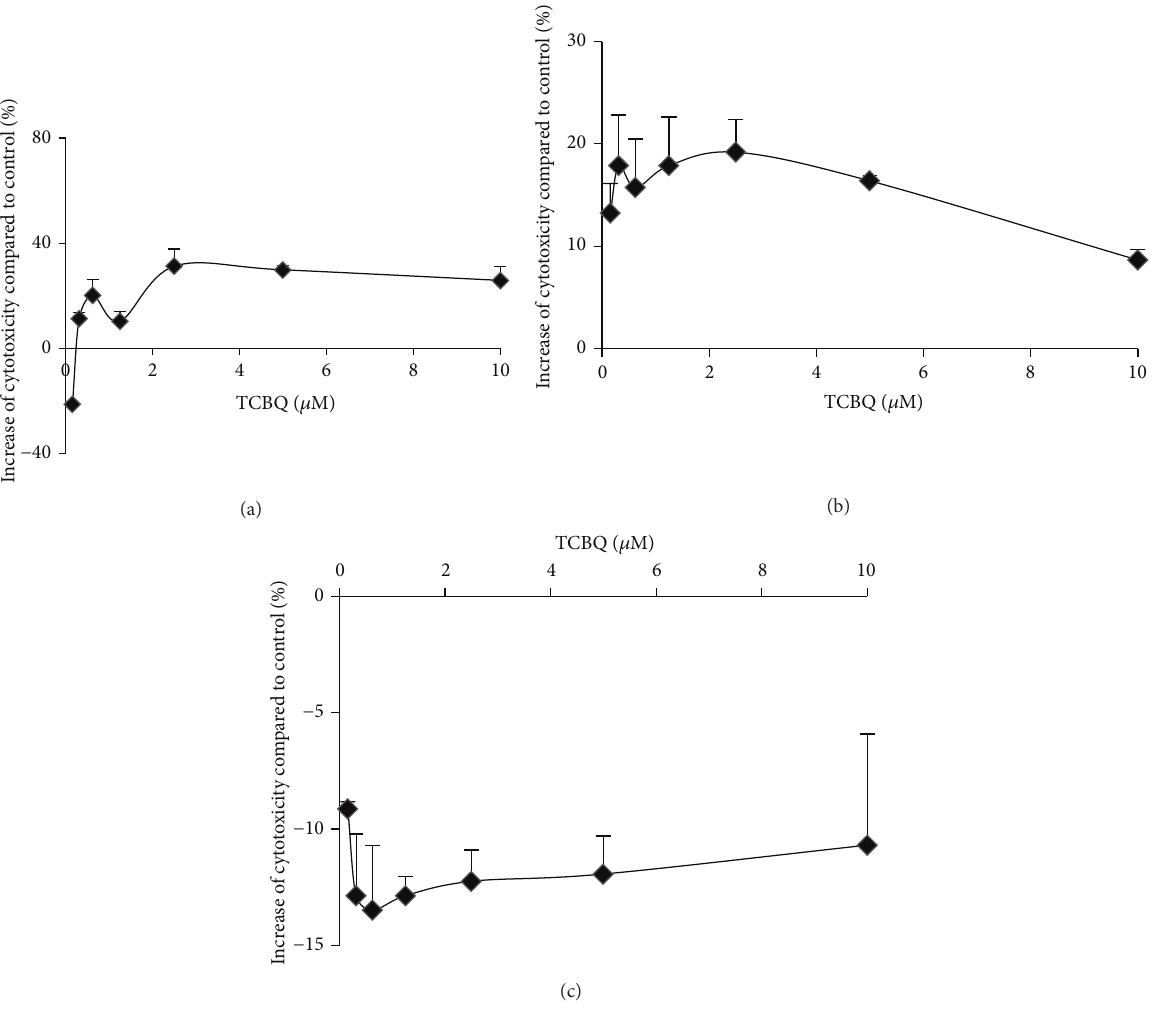
Figure 4: Cytotoxic effect of TCBQ towards human breast cancer MCF7 (a), Sk-Br-3 (b), and MDA-MB-231 (c) cells. The concentration of TCBQ was 0.16 𝜇 M, 0.31 𝜇 M, 0.63 𝜇 M, 1.25 𝜇 M, 2.5 𝜇 M, 5 𝜇 M, and 10 𝜇 M, respectively. Treatment with DMSO was used as negative control. Cytotoxicity was increased upon TCBQ treatment against both MCF7 and Sk-Br-3 cells. The increase of cytotoxicity (%) compared to control was statistically significant at TCBQ concentration of 0.16 𝜇 M, 0.63 𝜇 M, 1.25 𝜇 M, 2.5 𝜇 M, and 5 𝜇 M towards the MCF7 cells and at TCBQ concentration of 0.16 𝜇 M, 0.31 𝜇 M, 0.63 𝜇 M, 1.25 𝜇 M, 2.5 𝜇 M, and 5 𝜇 M towards the Sk-Br-3 cells, respectively. However, cytotoxicity was decreased upon TCBQ treatment towards the MDA-MB-231 cells. The decrease of cytotoxicity (%) compared to control was statistically significant at TCBQ concentration of 0.31 𝜇 M, 0.63 𝜇 M, 1.25 𝜇 M, 2.5 𝜇 M, 5 𝜇 M, and 10 𝜇 M. Statistical analysis was performed by one-way ANOVA with Dunnett’s comparison as posthoc